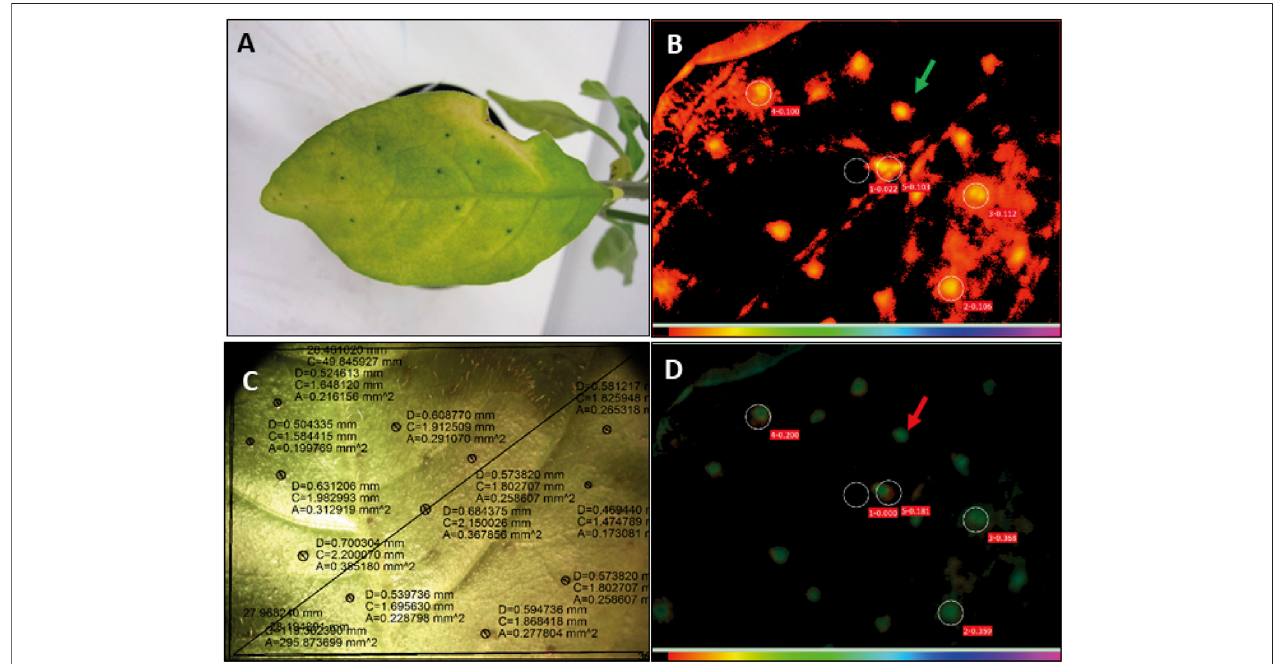
FIGURE 9 | Senescent leaves of Psychotria punctata show green nodules and higher photosynthetic activity in nodulated areas as compared to areas of leaf lamina. (A) Senescent leaf of P. punctata , showing still green nodules. (B) Visualisation of the chlorophyll fl uorescence parameters of a senescent leaf of P. punctata analysed with an Imaging PAM mini fl uorometer (Walz, Germany), maximal fl uorescence in light adapted state (Fm ’ ); red colour code indicates lower levels of fl uorescence light in nodulated areas (marked by green arrow) and thus higher photosynthesis rates; circels indicate the area, where the light curves have been measured. Circle number 1 indicates non nodulated leaf area, numbers 2 – 5 nodulated leaf areas. (C) Picture of the corresponding senescent leaf of P. punctata . Black circles surround leaf nodules, D, diameter of leaf nodule; C, circumference; A, area. (D) Quantum yield of photosystem II during illumination (Y(II)); green colour code indicates higher quantum yield in nodulated leaf areas (red